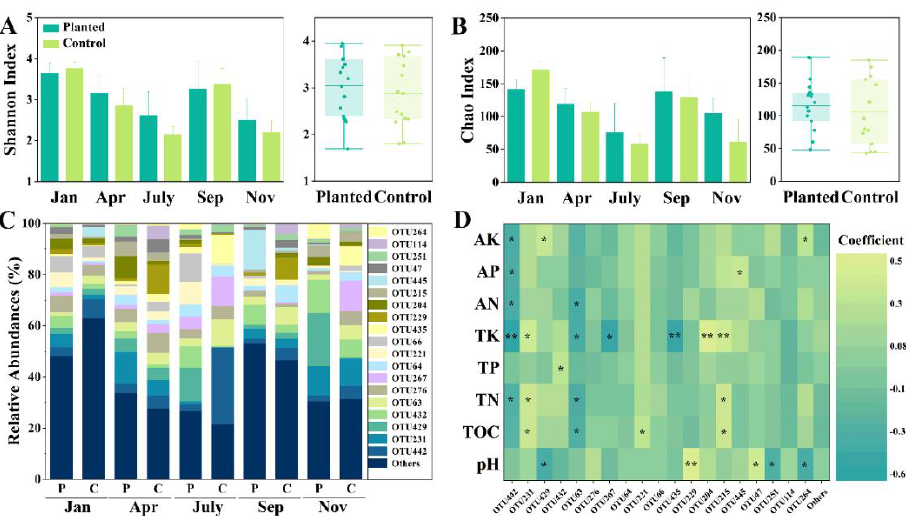
Figure 3. The annual variation in the basic AMF community properties. The error bar in ( A , B ) indicates the standard deviation ( n = 3 in the left part and n = 15 in the right part of each subfigure). P and C in the x -axis of ( C ) are abbreviations of planted and control, respectively. In ( D ), the star marker and double-star marker indicate significantly correlations at p < 0.05 and p < 0.01 level, respectively. As the p -values of the ANOISM tests were all more than 0.001, this indicates that